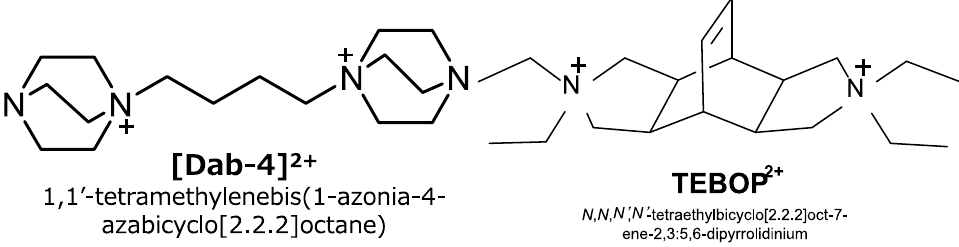
Figure 10. Frameworks of CHA-type SSZ-13 ( left ) and AFX-type SSZ-16 ( right ). Figure 11. Organic structure-directing agents (OSDAs) synthesized for SSZ-16 ( left ) and for AFX defined in this study ( right ).